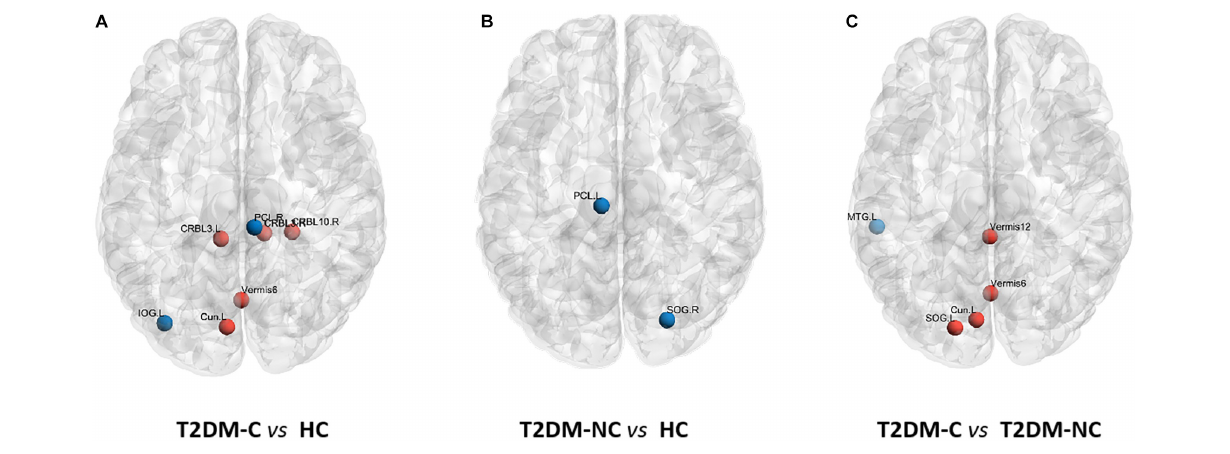
FIGURE 2 | Distribution of nodes properties with statistical differences between groups. (A) The distribution of the significant nodal properties between T2DM-C and HC group. (B) The distribution of the significant nodal properties between T2DM-NC and HC group. (C) The distribution of the significant nodal properties between T2DM-C and T2DM-NC group. Red color indicates increased nodal properties, and the blue color indicates decreased nodal